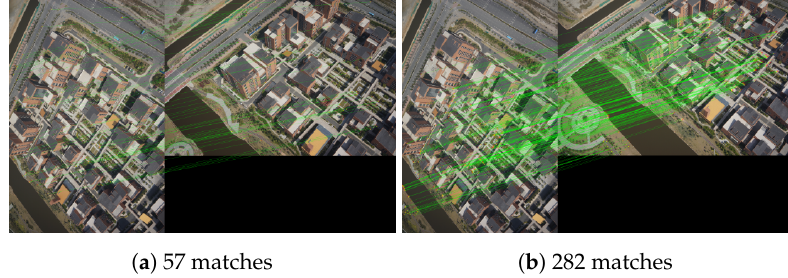
Figure 10. Feature matching of one image pair from dataset 3: ( a ) without the tiling strategy; ( b ) with the tiling